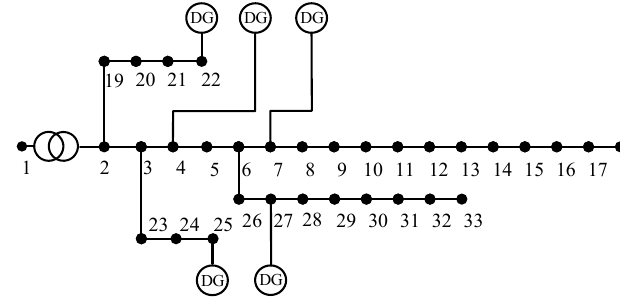
Figure 6. IEEE 33-bus system.